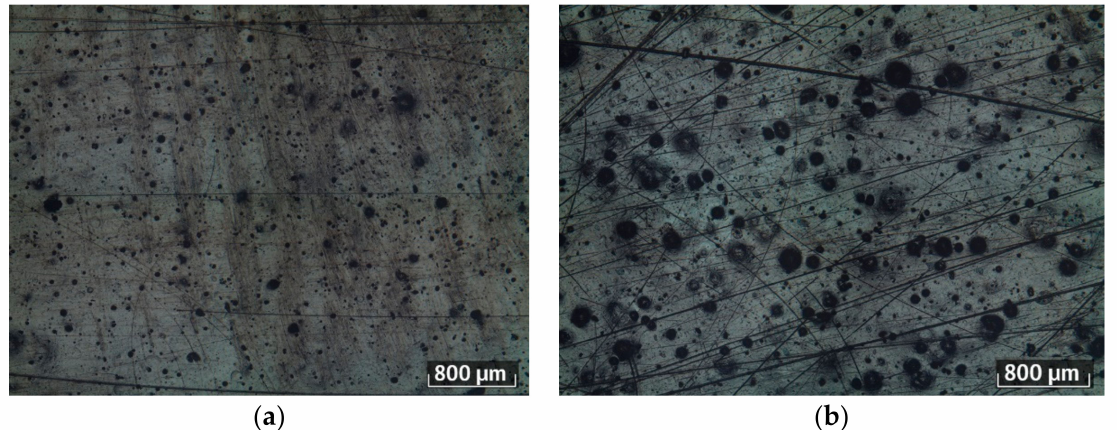
Figure 10. Microstructure of coating after test: ( a ) one decompression cycle; ( b ) two decompression cycle.